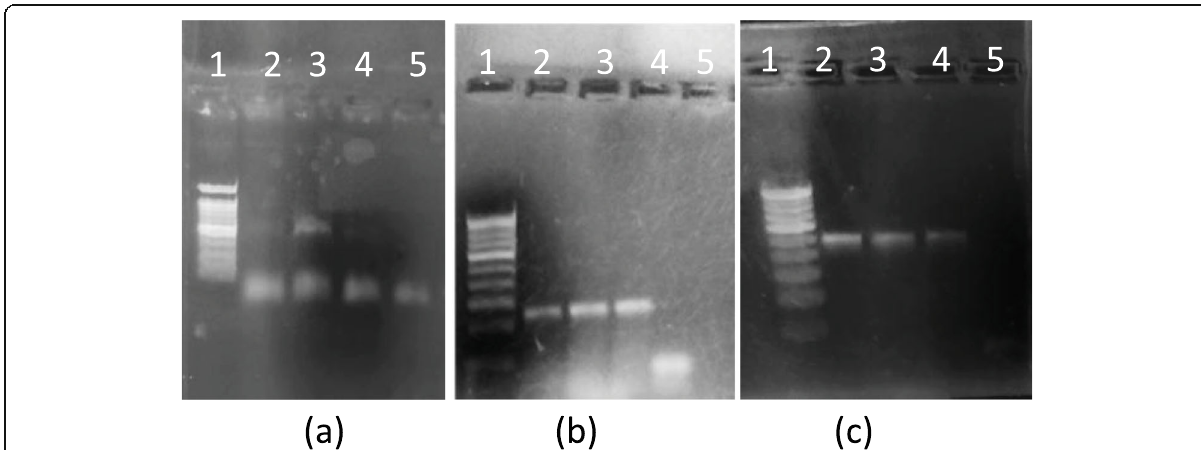
Fig. 3 Annealing temperature optimization. a 16s r-DNA amplification (S. aureus CS): lane 1 — 100 bp ladder, lane 2 — 55 °C, lane 3 — 57 °C, lane 4 — 58 °C, lane 5 — negative control. b β -galactocidase amplification using LacZ primers (E. coli. CS): lane 1 — 100 bp ladder, lane 2 — 55 °C, lane 3 — 57 °C, lane 4 — 58 °C, lane 5 — negative control. c ITS amplification using ITS primers (C. albicans CS): lane 1 — 100bp ladder, lane 2 — 55 °C, lane